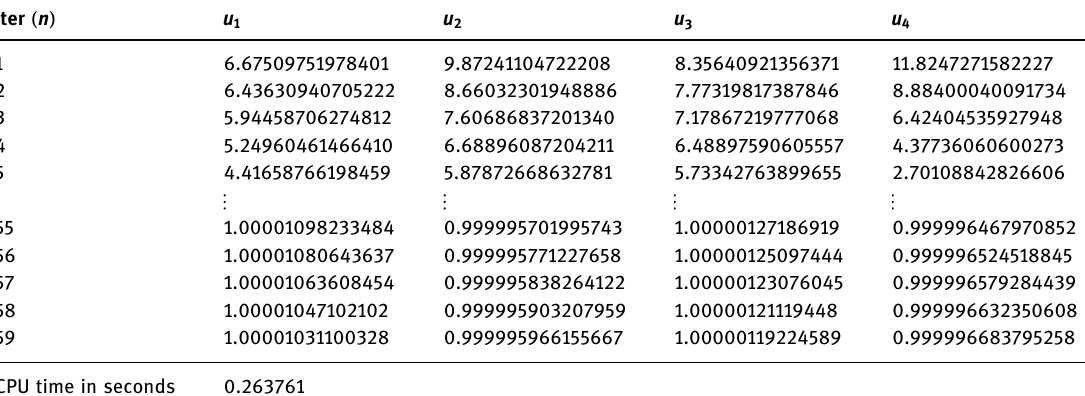
Table 7: Example 4.2: Numerical study of Algorithm 1 and